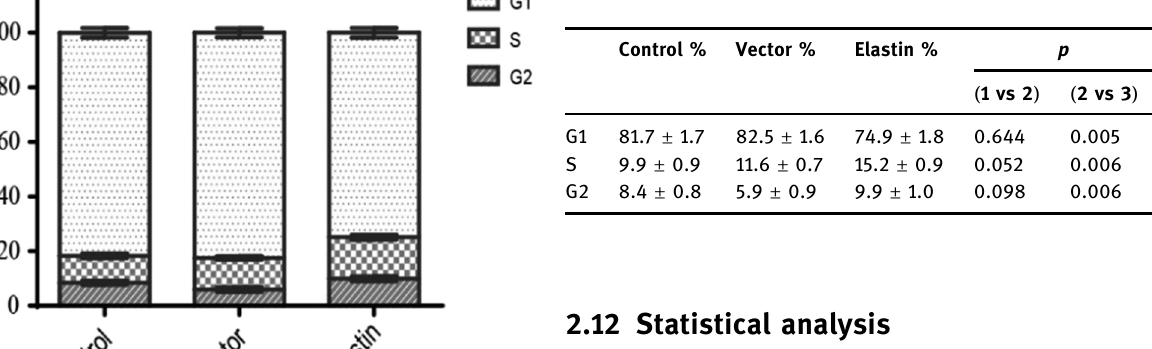
Table 1: Calculated ratio of G1, S, and G2 phases of BMSCs with